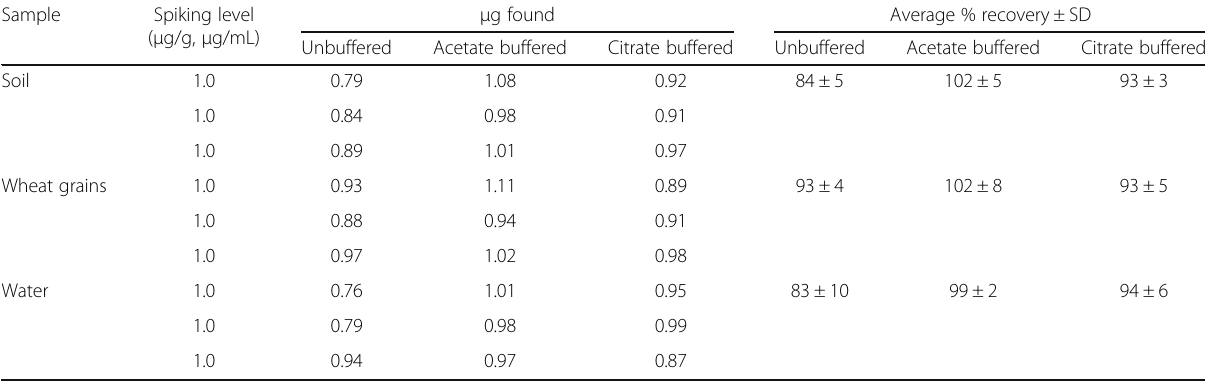
Table 2 Comparison of the buffered and unbuffered extraction strategies